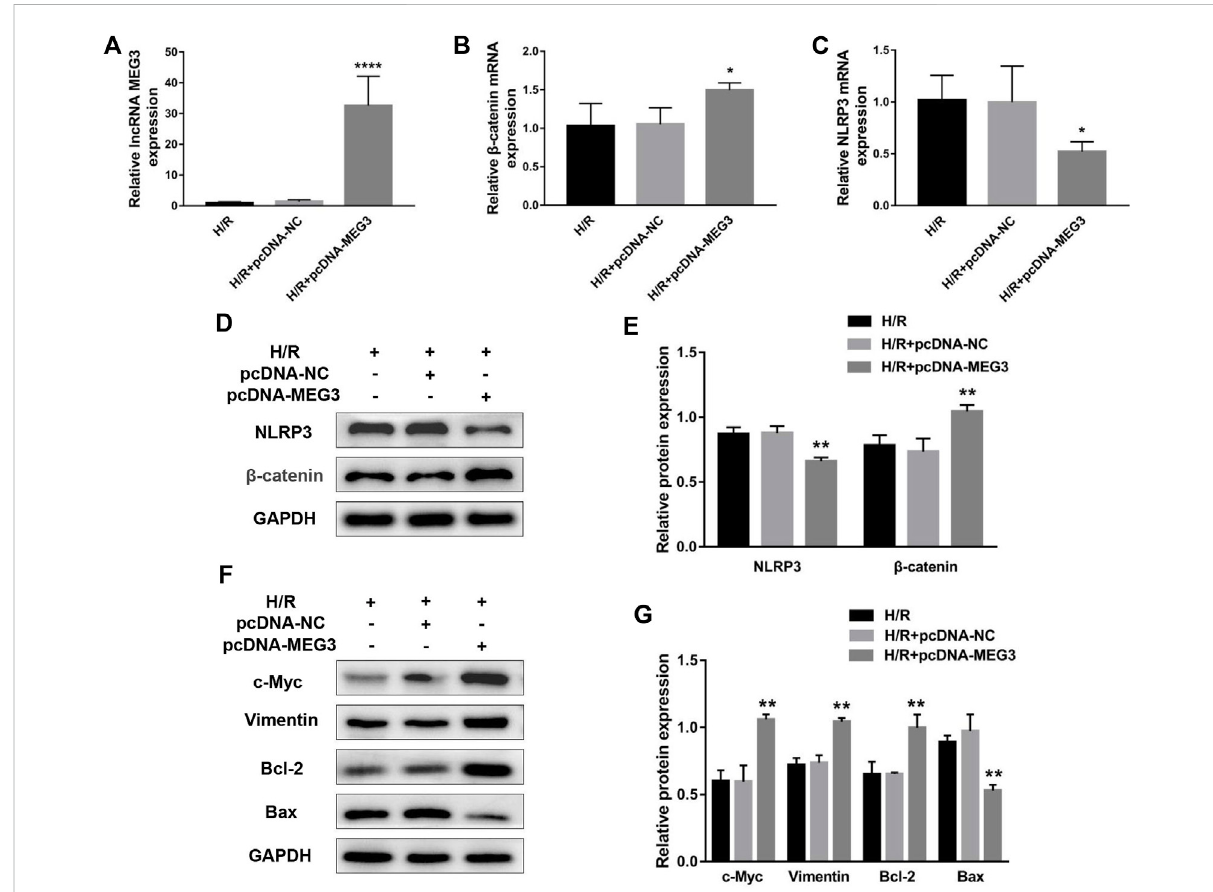
FIGURE 4 The overexpression of MEG3 altered the expression levels of β -Catenin and NLRP3 in trophoblast cells. The mRNA expression levels of MEG3 (A) , β -Catenin (B) and NLRP3 (C) after overexpression of MEG3 were assessed by qRT ‒ PCR ( n = 4/group). (D,E) The protein expression levels of β - Catenin and NLRP3 after overexpression of MEG3 were detected by Westernblot ( n = 3/group). (F,G) The expression levels of c-Myc, Vimentin, Bcl- 2, and Bax were assessed by Western blotting ( n = 3/group). GAPDHwas used as an endogenous control. * p < 0.05; ** p < 0.01; **** p <